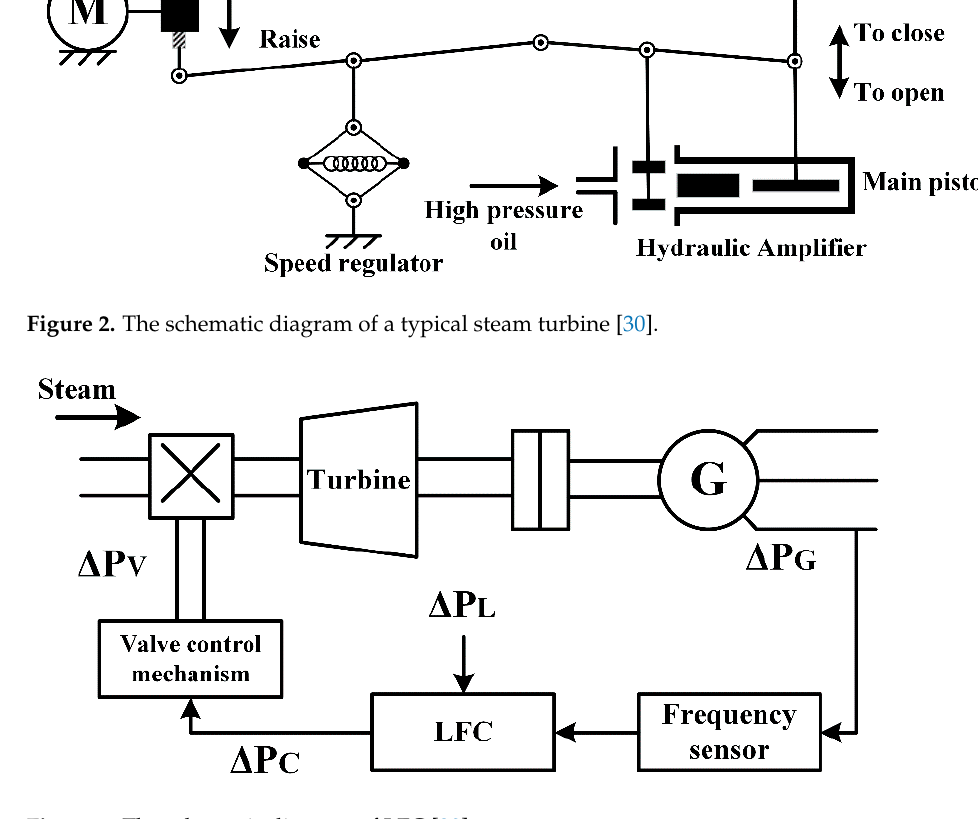
Figure 3. The schematic diagram of LFC [30].